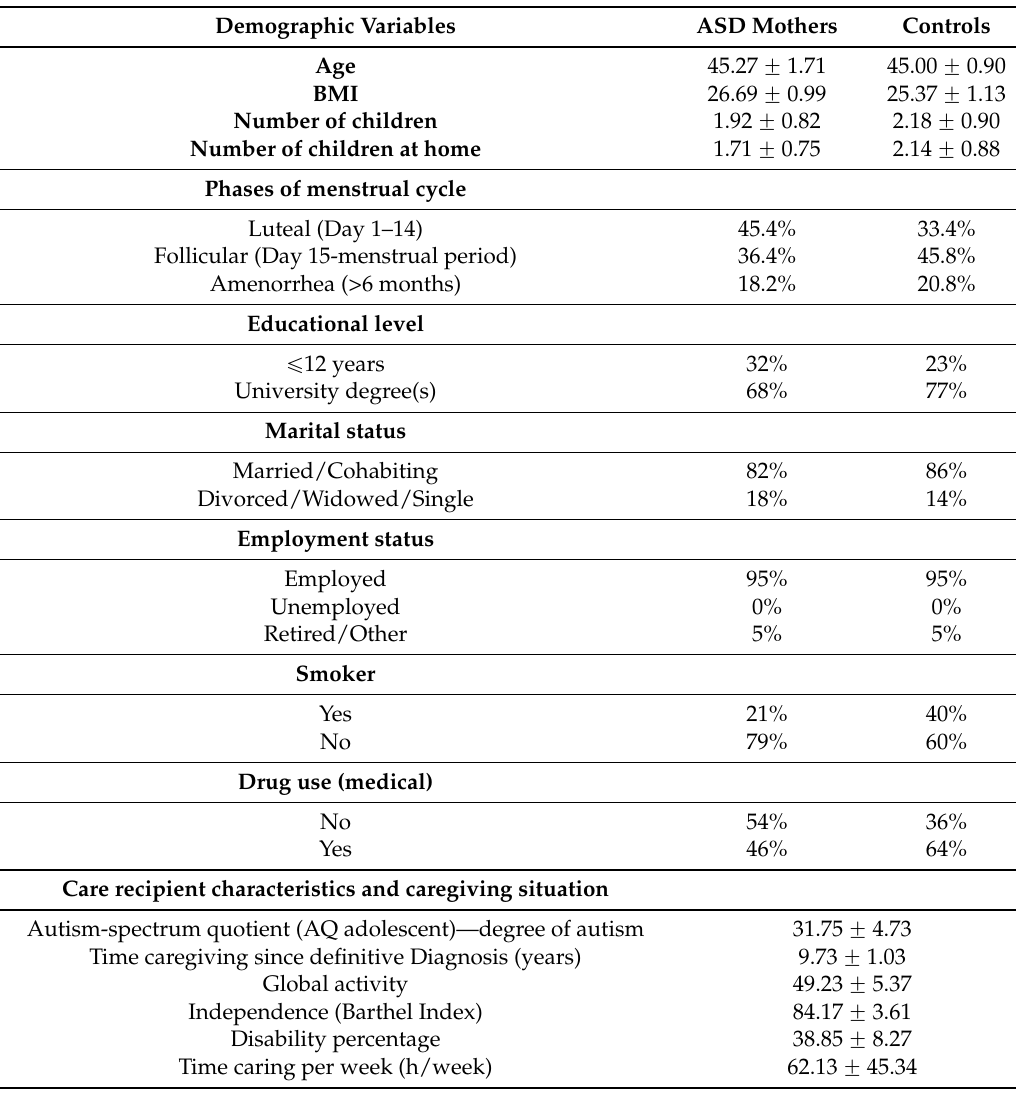
Table 1. Mean ˘ SD of age and body mass index (BMI) and demographic variables for mothers with autism spectrum disorders (ASD) offspring (ASD mothers) and